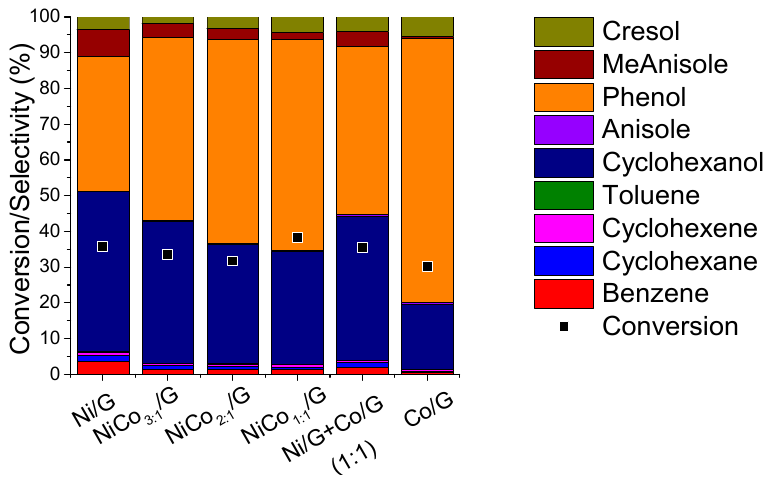
Figure 6. Evolution of the TOF conversion with the Co content in the catalysts.